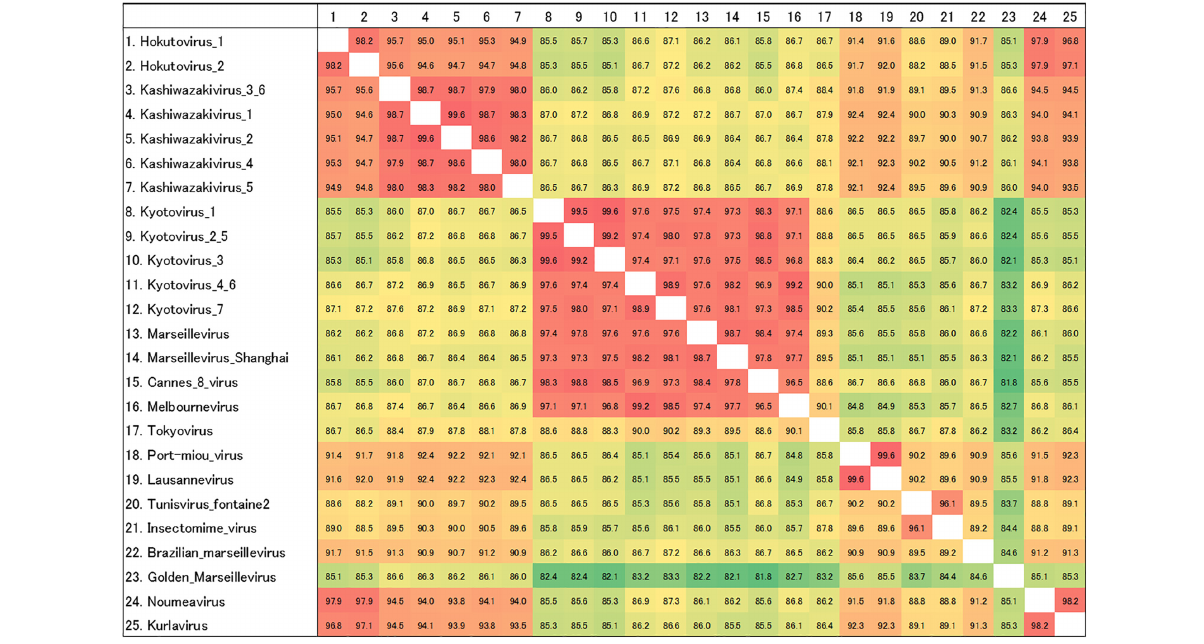
FIGURE 8 | Pairwise sequence identity of MCP genes. The pairwise sequence identities are displayed in percentage. Color of each box corresponds to the order of values from red (high) to green (low). The numbers on the left of the species name match to the numbers on the first